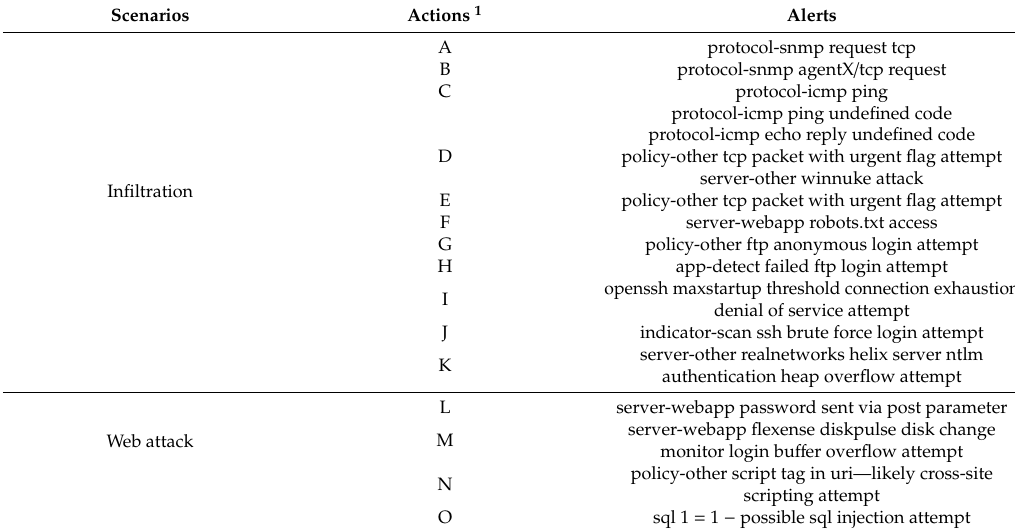
Table 3. Extracted intrusion